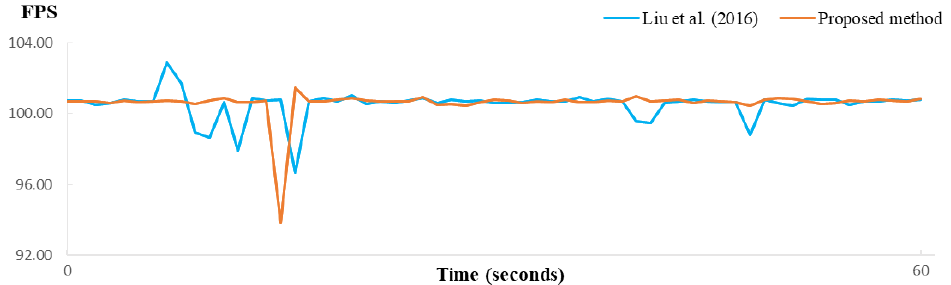
Figure 18. Average frames per second (FPS) for indoor scenes inside the Building Information Model (BIM) model when the outdoors is not